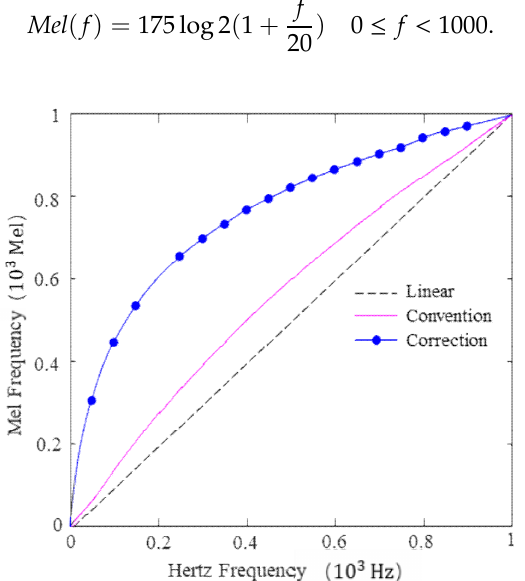
Figure 7. Local Transformation between the Hertz and Mel frequencies.